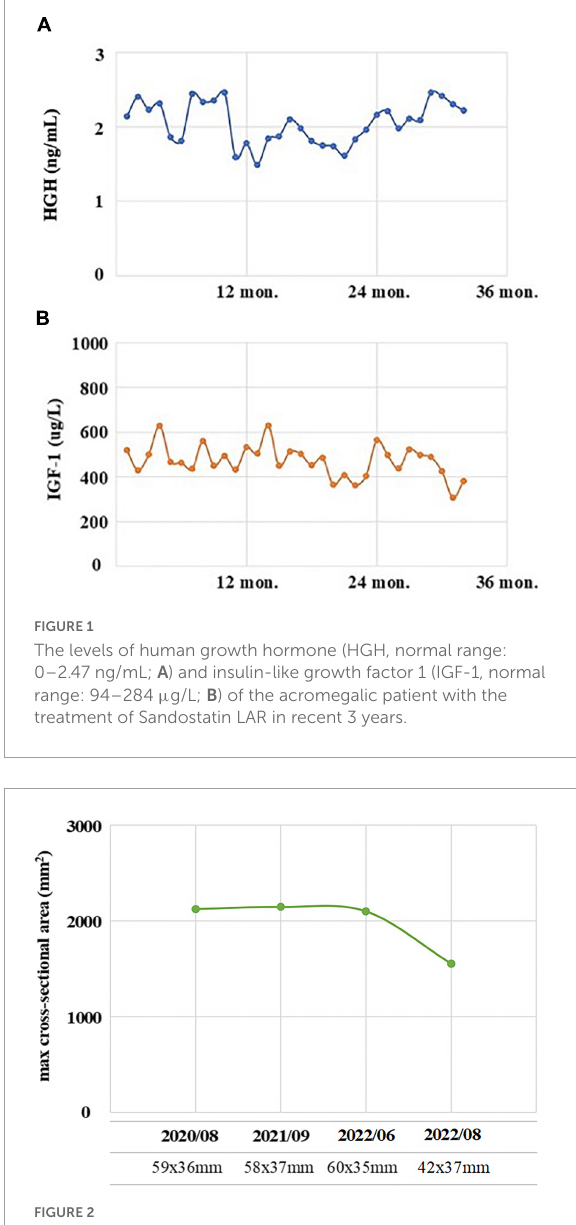
FIGURE2 The maximum cross-sectional area (mm 2 ) of the pituitary macroadenoma measured by pituitary magnetic resonance imaging (MRI) of the acromegalic patient with the treatment of Sandostatin LAR in recent 3